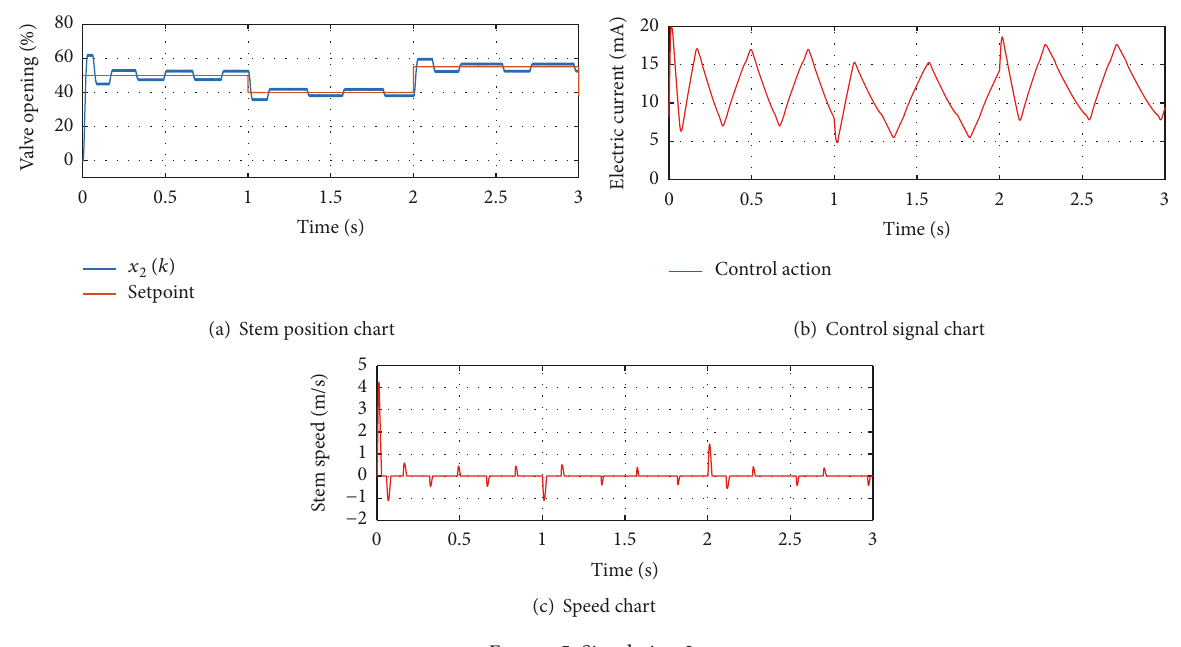
Figure 5: Simulation